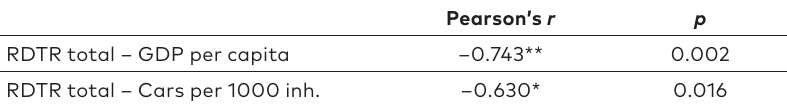
Table 5. Correlation between the total road